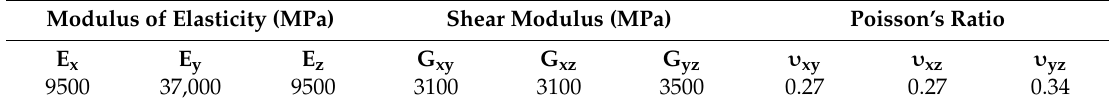
Table 2. Material constants of orthotropic fiber